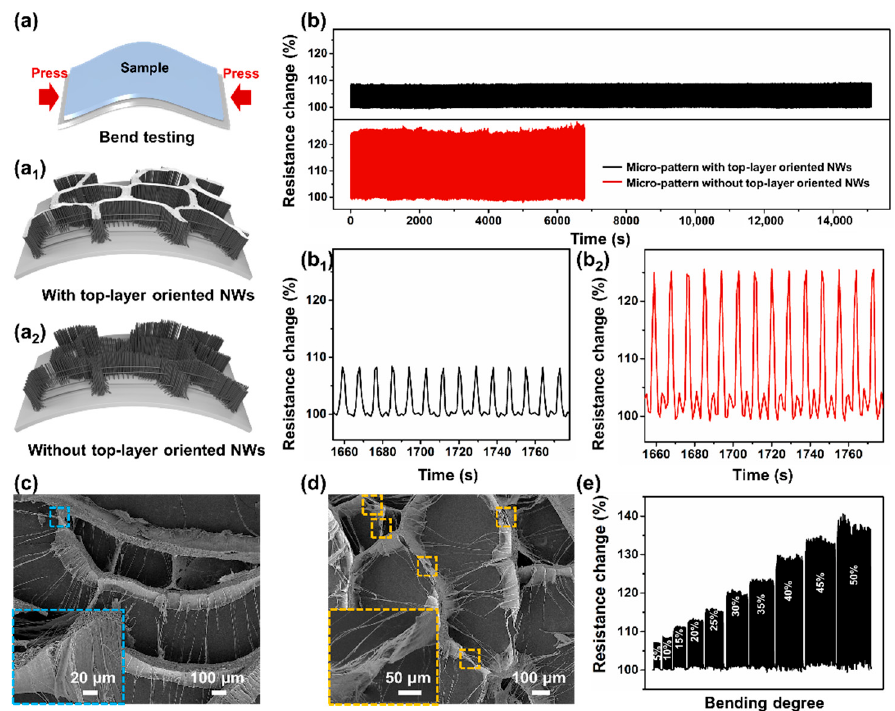
Figure 3. Bending stability of the as-prepared multidimensional aligned NWs array. ( a ) Schematic illustration of the testing process. ( a 1 , a 2 ) The NWs array with and without oriented AgNWs on top layer. ( b ) The resistance changes of the NWs array with and without top-layer oriented AgNWs under bending/unbending motion at bending degree of 10%. ( b 1 , b 2 ) An enlarged picture of ( b ) curves for the NWs array with and without top-layer oriented AgNWs, respectively. ( c , d ) The SEM picture of the NWs array with and without oriented NWs on the top-layer after 750 bending cycles. The typic enlarged view was shown in the illustration. ( e ) The resistance changes of the as-prepared multidimensional aligned NWs array under bending/unbending motion at different bending degree of 5%, 10%, 15%, 20%, 25%, 30%, 35%, 40%, 45%, and 50%, respectively.